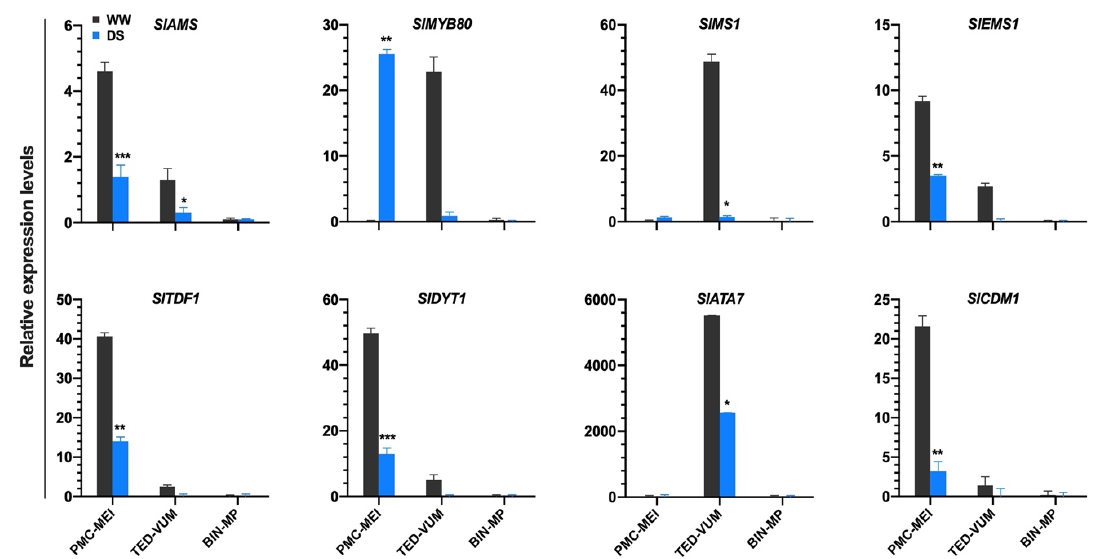
Figure 5. Expression level changes of tapetum-expressed genes in three groups of tomato anthers of different developmental stages under drought stress. Gene expression levels were based on the number of fragments per kilobase of transcript sequence per millions (FPKM) base pairs sequenced from RNA-Seq data and presented as means ± SD ( n = three replications, 24 plants each). * p < 0.05; ** p < 0.01; *** p < 0.001 ( t -test).